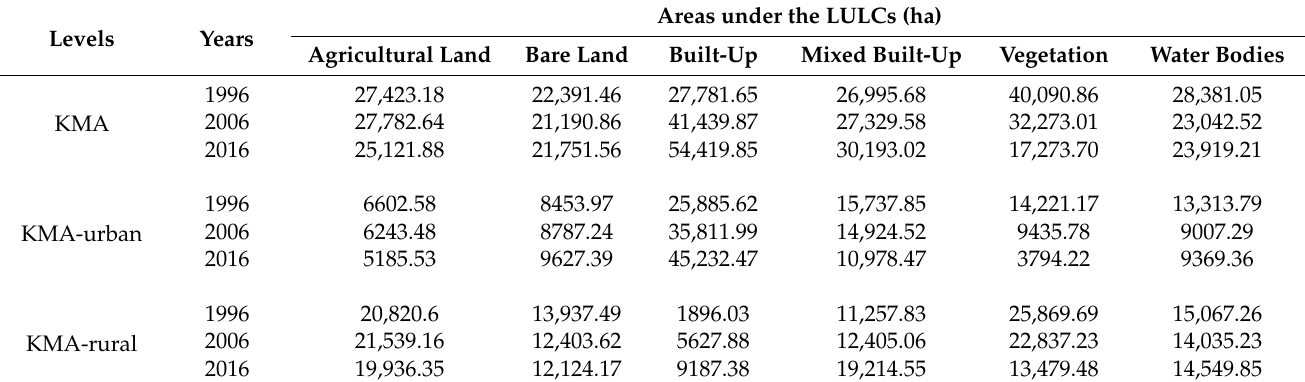
Table A6. Statement of class areas (CA in ha) under the different LULCs in 1996, 2006, and 2016.